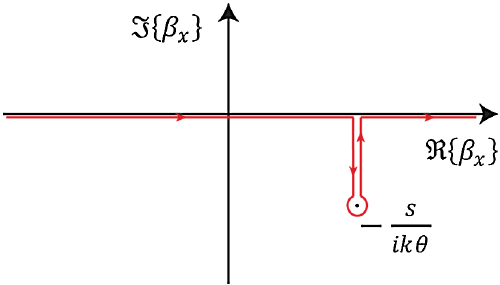
FIG. 1. Landau contour in the complex (cid:7) mation of the integration path makes the plasma dielectric function analytical as a function of s .